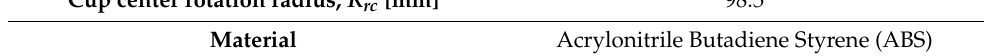
Table 2. Characteristics of the anemometer used for the TASEC-Lab